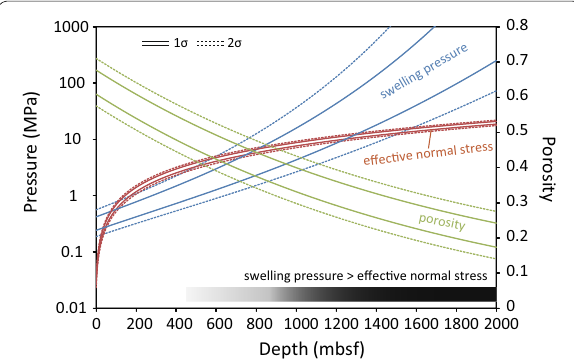
Fig. 4 Porosity and swelling pressure curves at depths of the fault zone. Swelling pressure (blue), effective normal stress (red) and porosity (green) at depths of the fault zone extrapolated from the porosity-depth and porosity-swelling pressure curves (Figs. 1b and